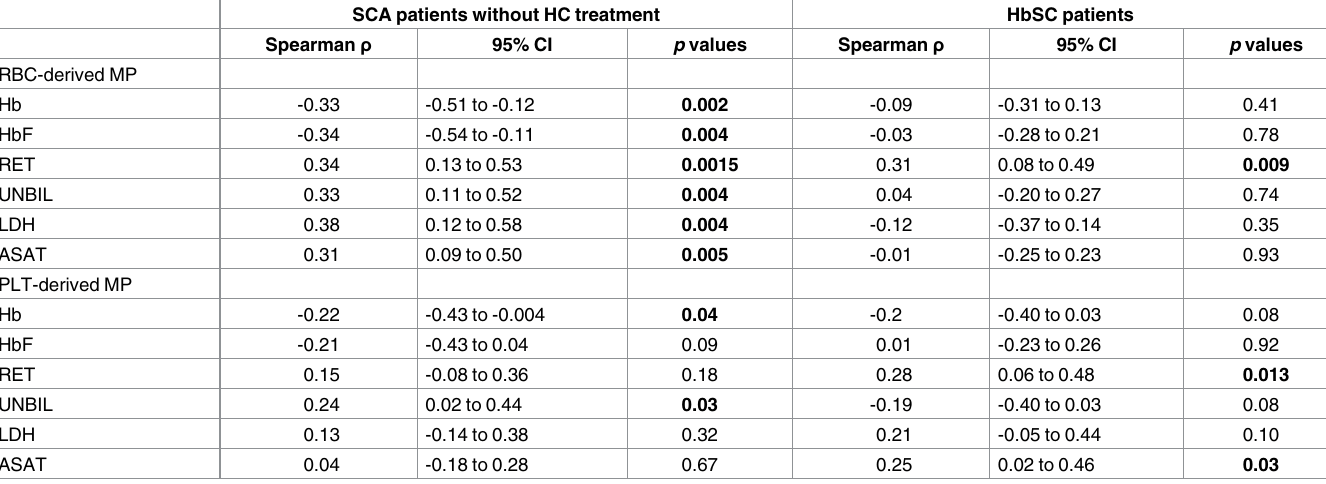
Table 3. Correlation between MP concentrations and markersof hemolysis/anemia in SCD